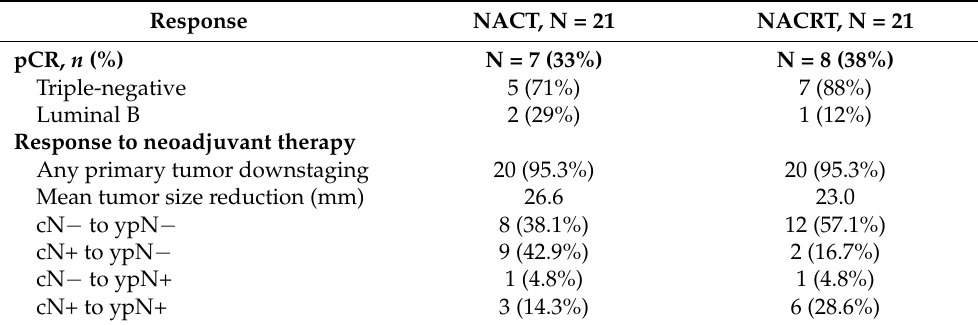
Table 2. Response to neoadjuvant therapy.